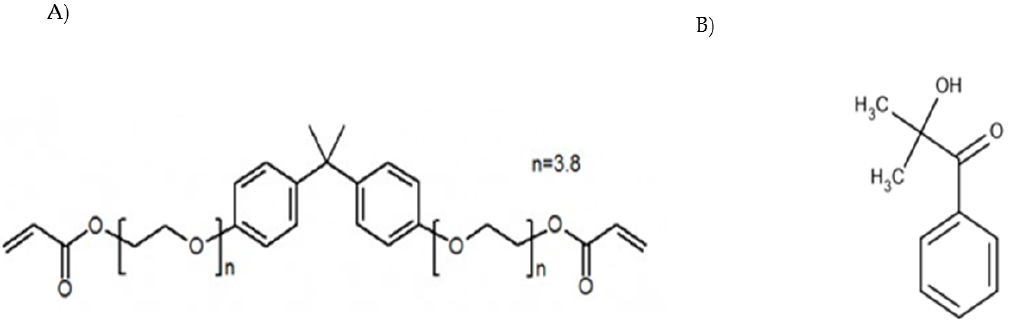
Figure 1. Chemical structures of Ebecryl 150 ( A ) and Irgacure 1173 ( B ).